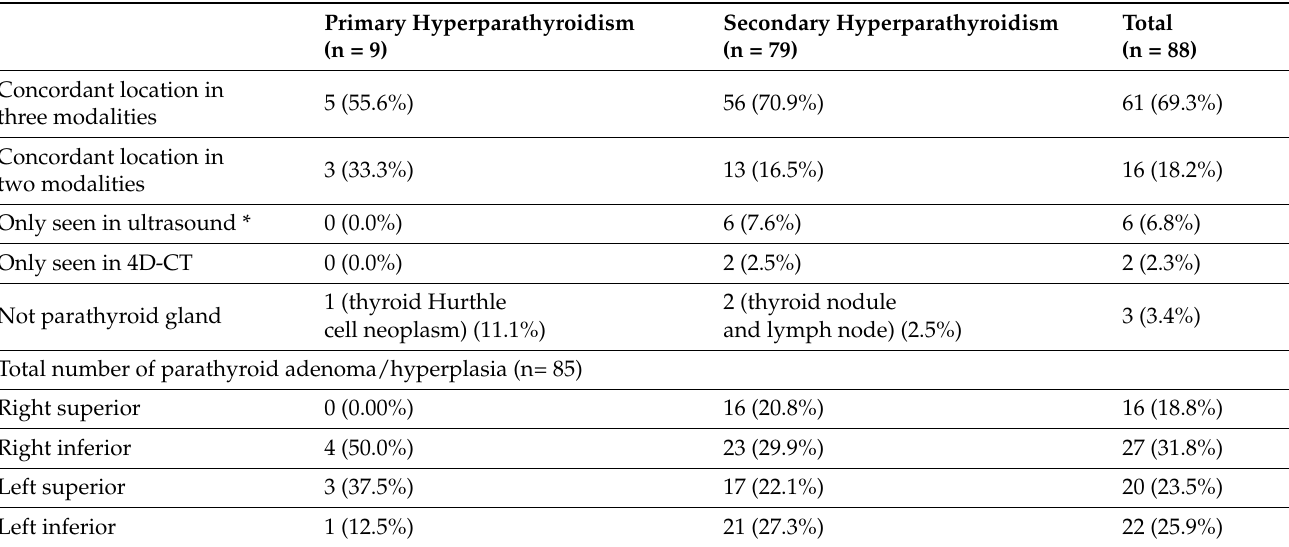
Table 2. Characteristics of Positive Lesions (Number of